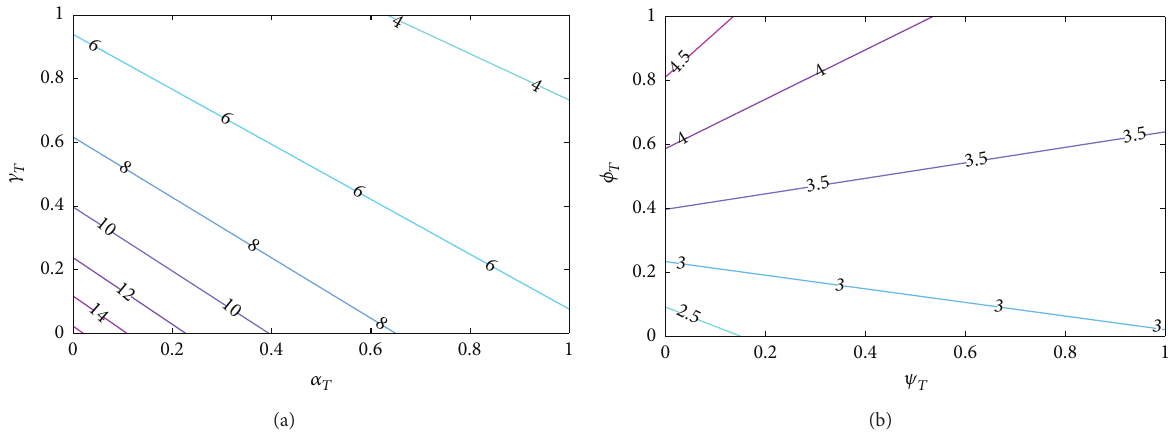
Figure 3: Contour plot of the reproduction number ( R 𝑇 ) of model (2) as: (a) a function of isolation rate ( 𝛼 𝑇 ) and treatment rate ( 𝛾 𝑇 ); (b) a function of return rate from lost to follow-up ( 𝜓 𝑇 ) and lost to follow-up rate ( 𝜙 𝑇 ). Parameter values used are as given in Table 2.